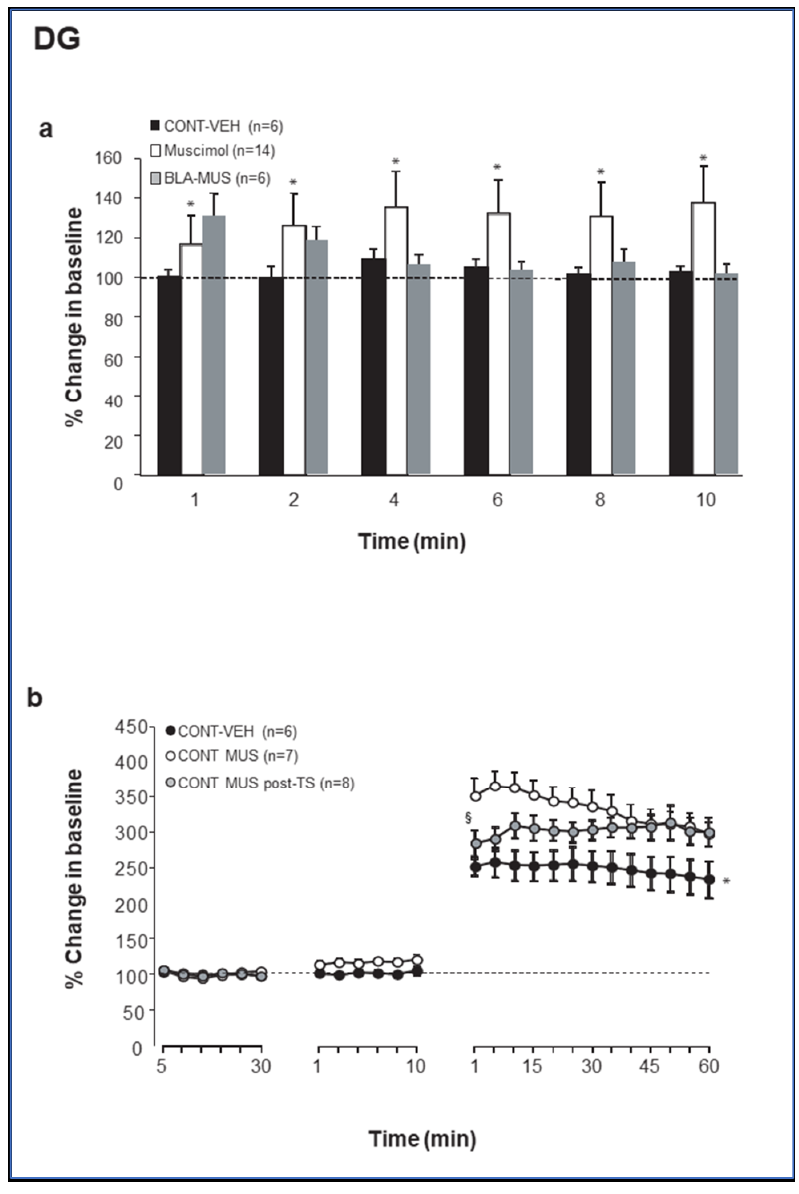
Figure 2. ( a ) Change in baseline excitationin DG following microinfusion of Muscimol in the BLA. ns: not significantly di ff erent; * significantly di ff erent from both CONT-VEH and CONT-MUS-post ( p < 0.05). (Muscimol— CONT-MUS and MUS - BLA [prior to BLA priming] groups). ( b ) Muscimol microinfused either before or after TS-induced LTP enhanced LTP in DG but in a slightly di ff erent way. Muscimol before enhanced LTP from the start, while muscimol post induced a developing enhancement of the potentiation over time. * Control-MUS is significantly di ff erent from both CONT-VEH and CONT-MUS-post ( p < 0.05); § CONT-VEH is significantly di ff erent from both Control-MUS and Control-MUS-post ( p <